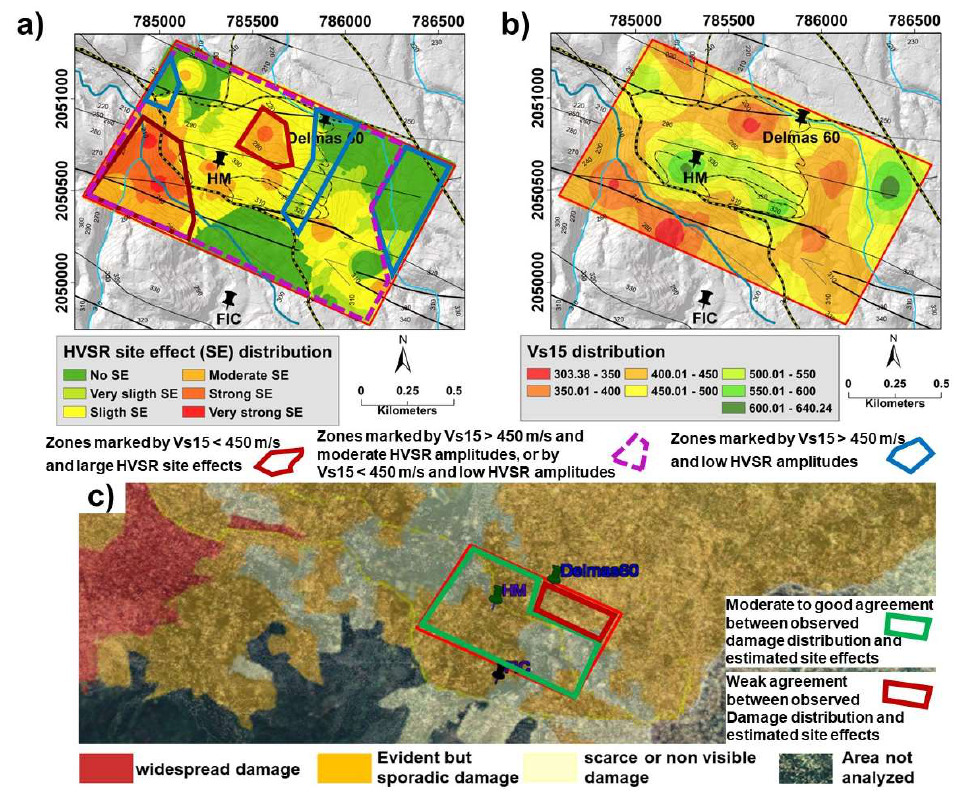
Figure 4. Map ( a ) outlines the distribution of the combined HVSR resonance frequency and peak amplitude site effect characteristics; map ( b ) presents the interpolated V s15 -values; map ( c ) presents the distribution of the damages; the red line delimits the study area; modified from